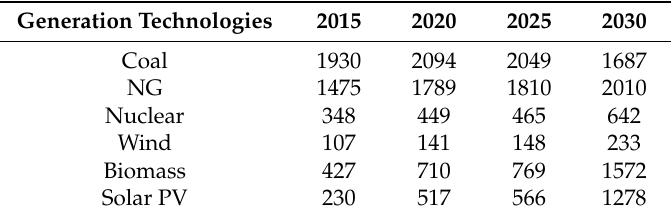
Table 10. Global cumulative capacity deployments (in GW) in IEA 450 scenario [72].